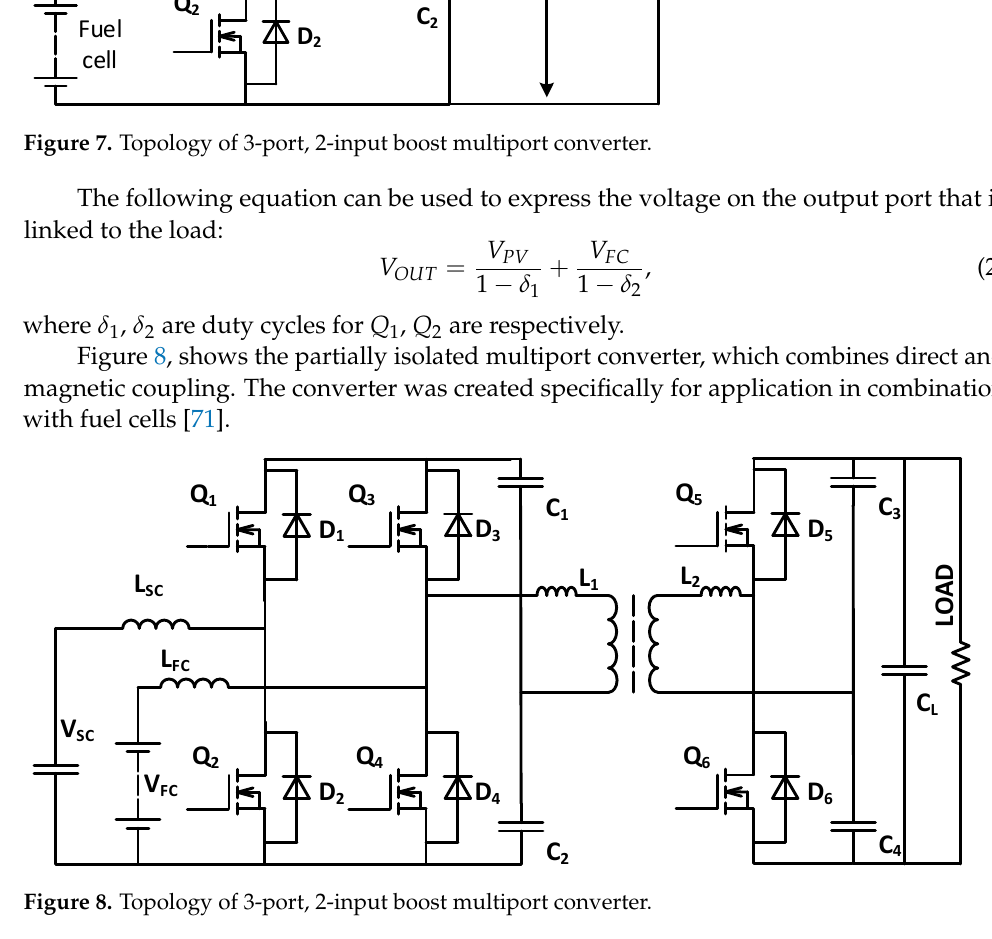
Figure 8. Topology of 3-port, 2-input boost multiport converter.